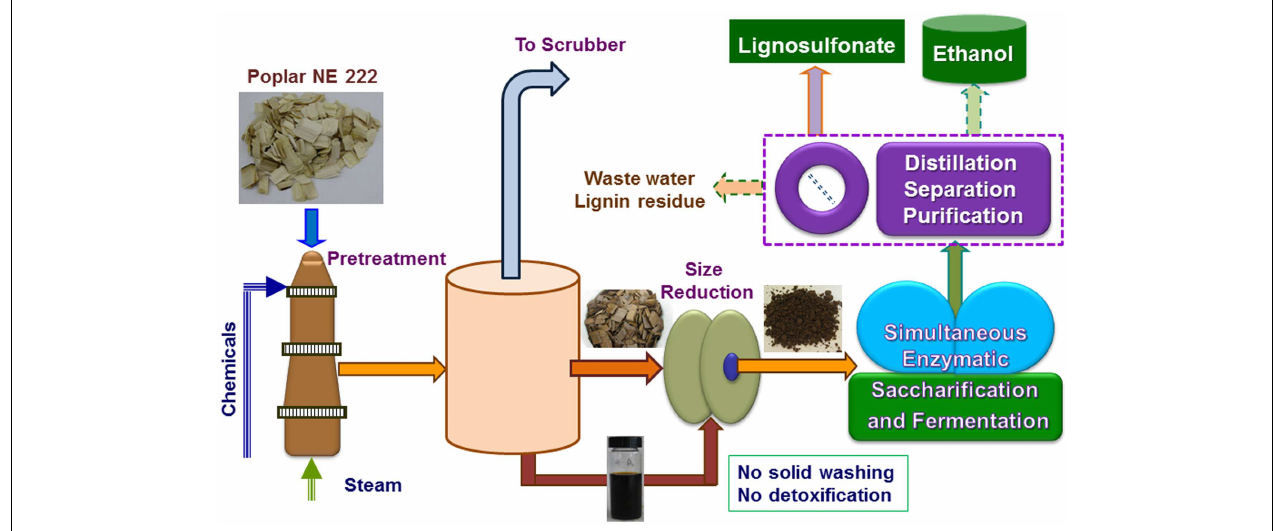
FIGURE 1 |A schematic block flow diagram shows the pilot-scale pretreatment of poplar NE222 by SPORL along with downstream enzymatic saccharification and fermentation . Process boxed by dashed lines was partially conducted.